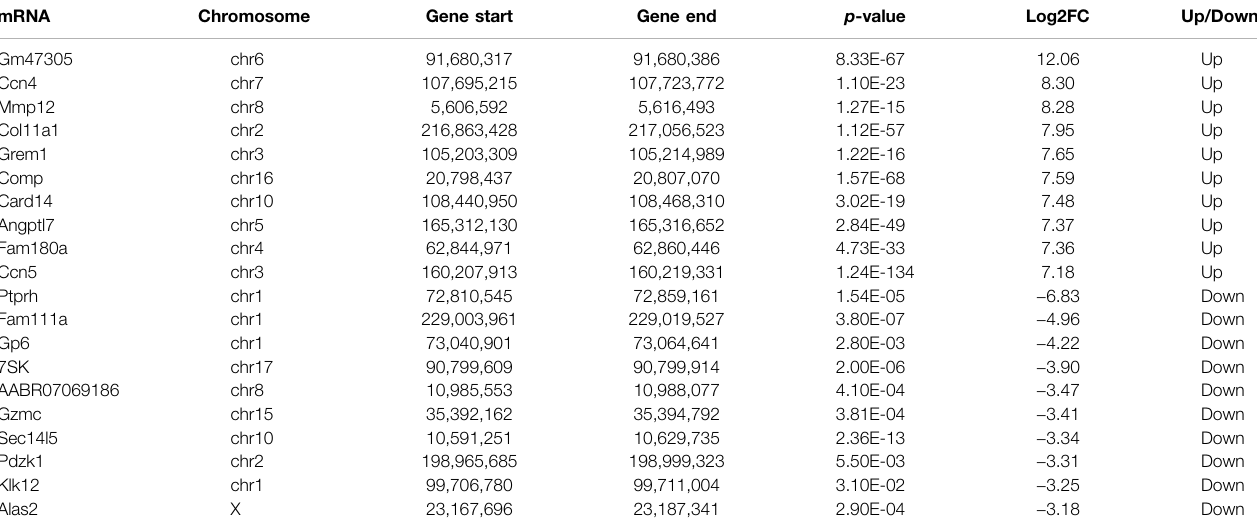
TABLE 2 | Top 20 differentially expressed mRNAs.